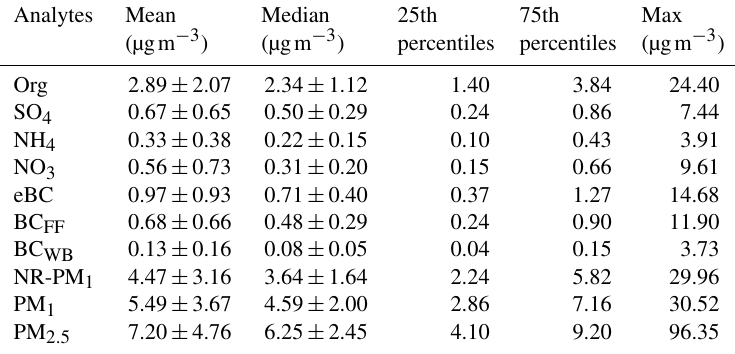
Table 1. The concentrations of PM 1 constituents measured by ACSM (10 June 2015–31 December 2019) and MAAP (1 June 2015–31 De- cember 2019) and of PM 2 . 5 measured by TEOM (1 June 2015–31 December 2019). NR-PM 1 was obtained by summing all the constituents measured by the ACSM, while PM 1 is the sum of NR-PM 1 and eBC from MAAP. The eBC from fossil fuel combustion (BC FF ) and from wood burning (BC WB ) measured by the Aethalometer (30 November 2015–31 December 2019) is also included. Hourly mean ( ± standard deviation), median ( ± median absolute deviation), 25th and 75th percentiles, and maximum concentrations are included. Analytes Mean Median 25th (µgm − 3 ) (µgm − 3 ) percentiles